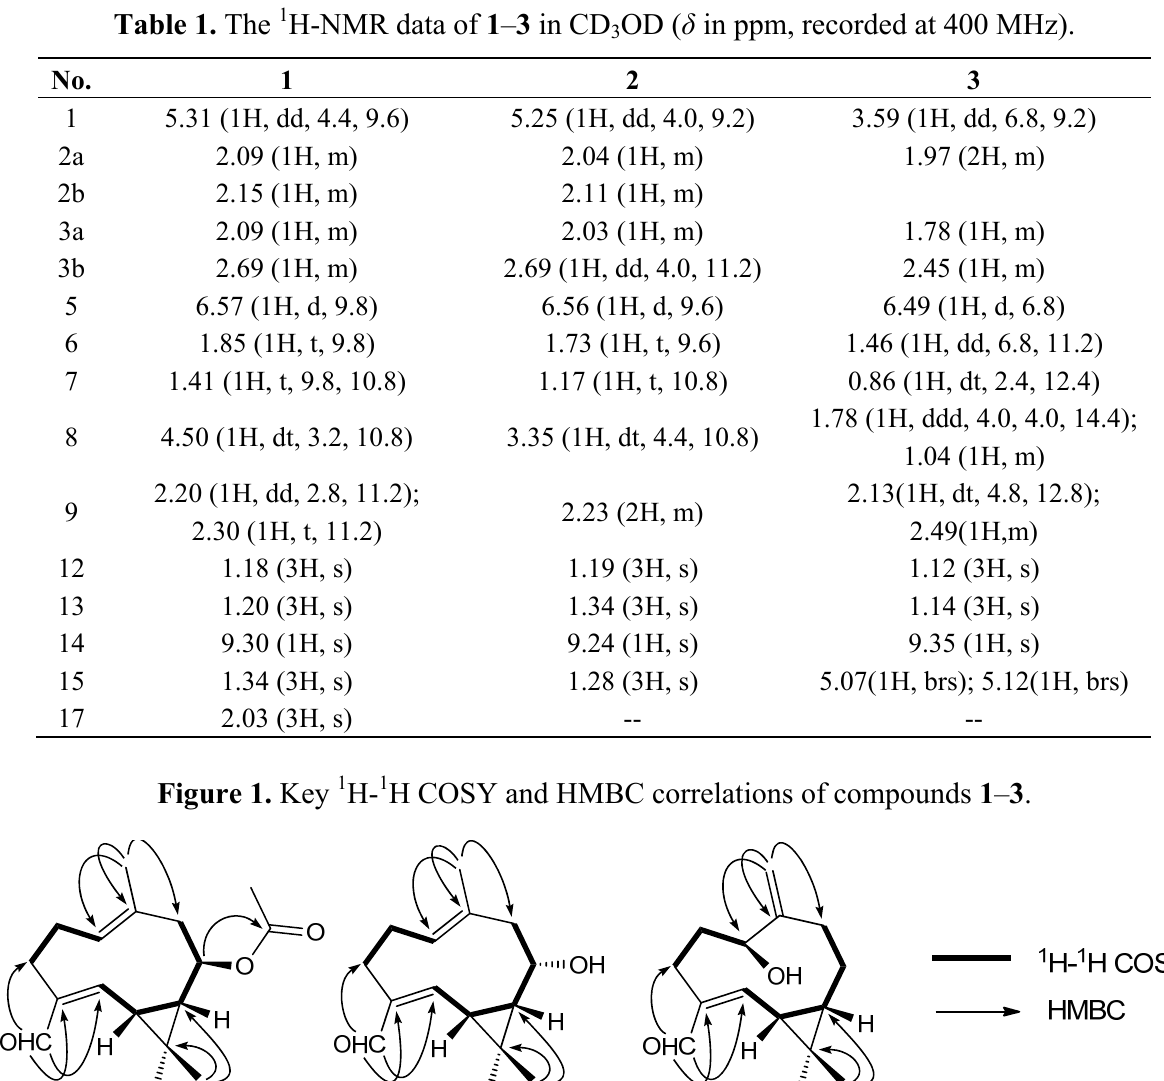
Table 1. The 1 H-NMR data of 1 – 3 in CD